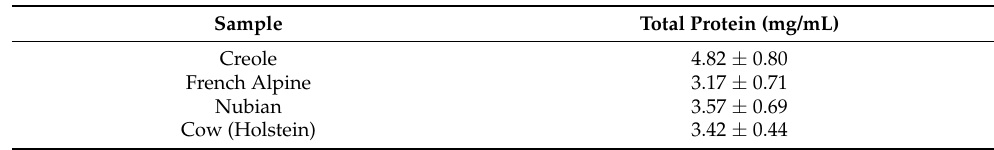
Mean ± S.D, n = 10 animals by breed and